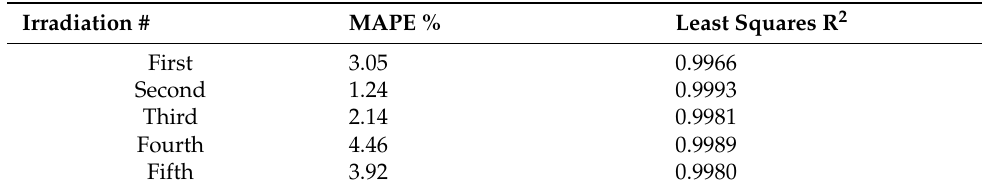
Table 3. Linearity values for Formulation 1 for five successive irradiations. The mean average percent error (MAPE) calculation includes cuvettes dosed with 1–10 Gy. The R 2 coefficient of linearity is also included.